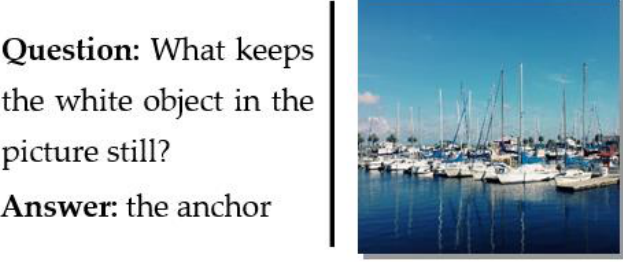
Figure 1. An instance from the OK-VQA dataset.